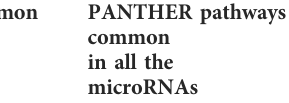
TABLE 4 List of common pathways in TargetScan and miRDB for two upregulated and two downregulated microRNA from NGS study. microRNAs KEGG pathways